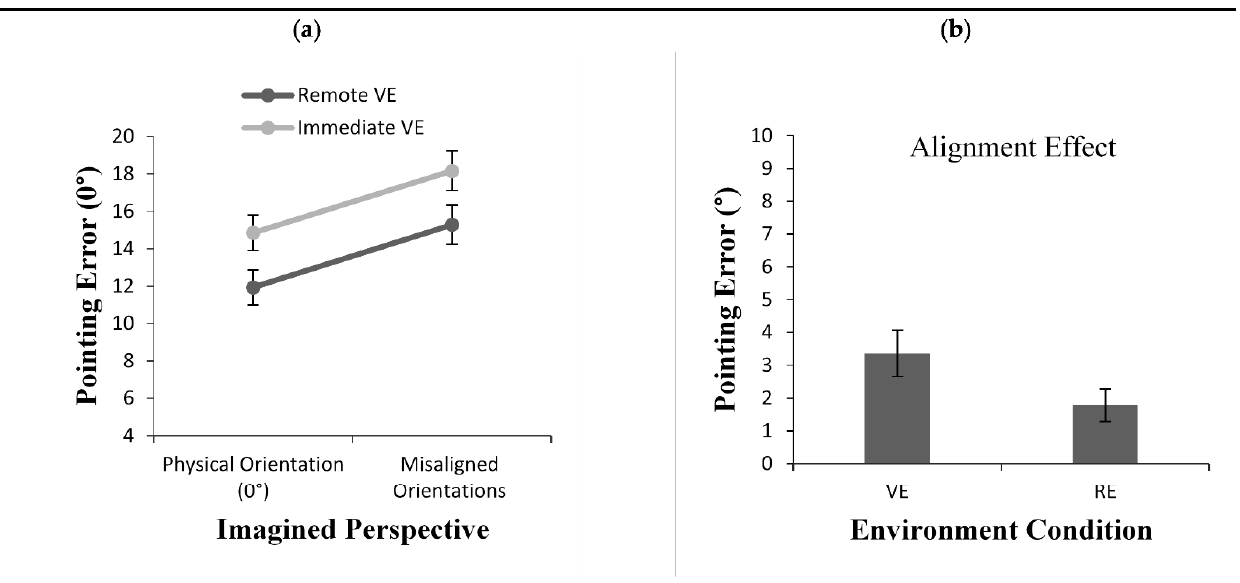
Figure 5. Pointing error ( a ) as a function of imagined perspective and alignment effect for pointing error ( b ) across test conditions (Remote VE vs. Immediate VE) in Experiment 1 and Experiment 2. Error bars represent standard errors from the ANOVA and from a t -test, respectively.